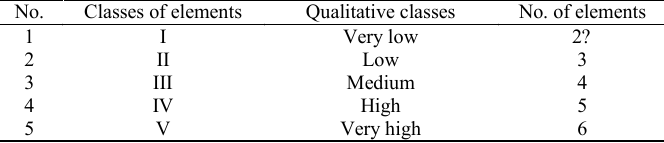
Fig. 2: The flow diagram of the proposed research Table 3: Classes of elements at risk in the study area (Ownegh,